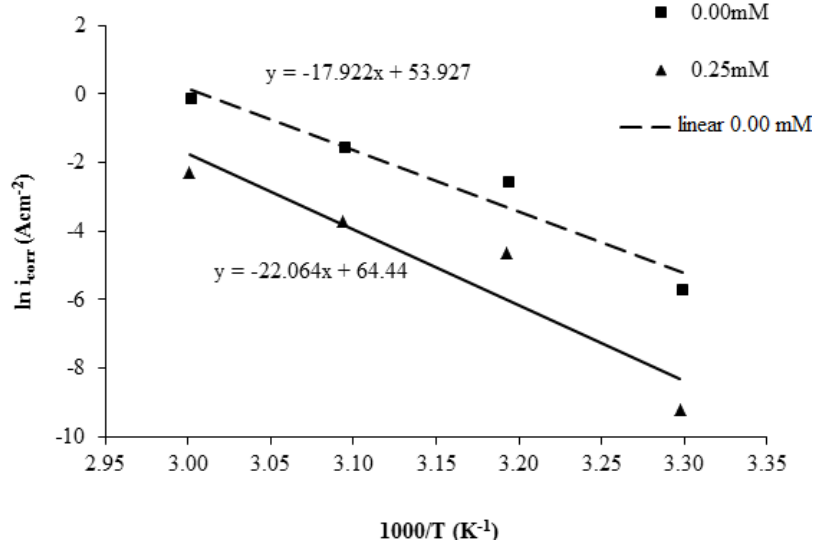
Figure 6. The Arrhenius plot for mild steel in 1.0 M H concentrations of the corrosion inhibitor.